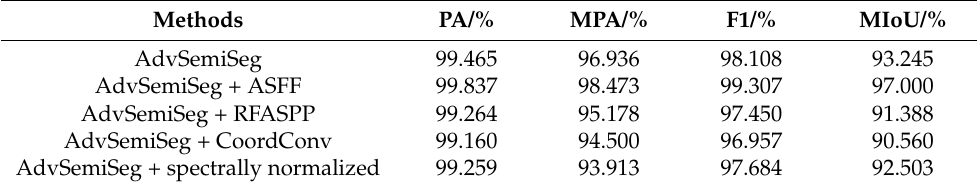
Table 3. The results of each module on the synthesized assembly depth image dataset.